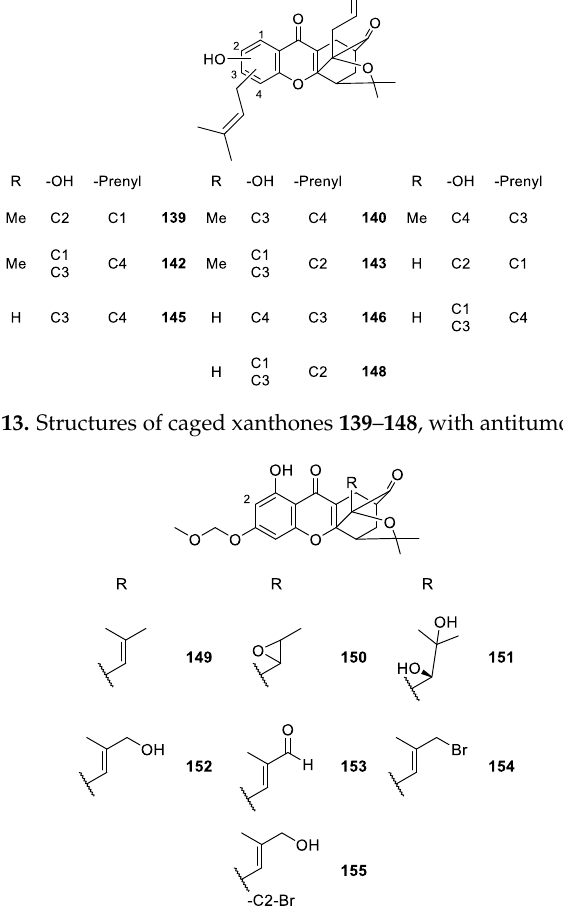
Figure 14. Structures of gambogic acid derivatives 149 – 155 , with antitumoral activity. Table 1. Summary of the biological activities of synthetic CDXs inspired in natural xanthones.